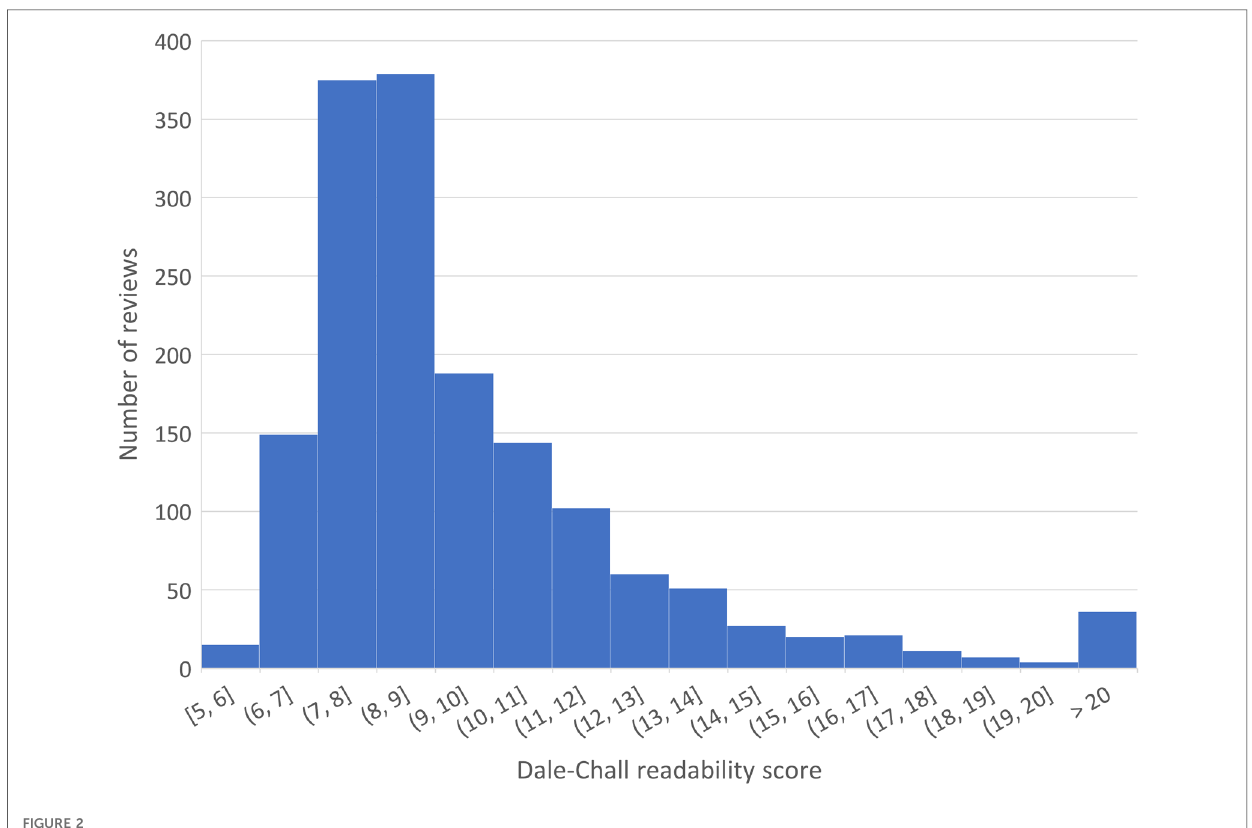
FIGURE 2 Distribution of the Dale – Chall readability